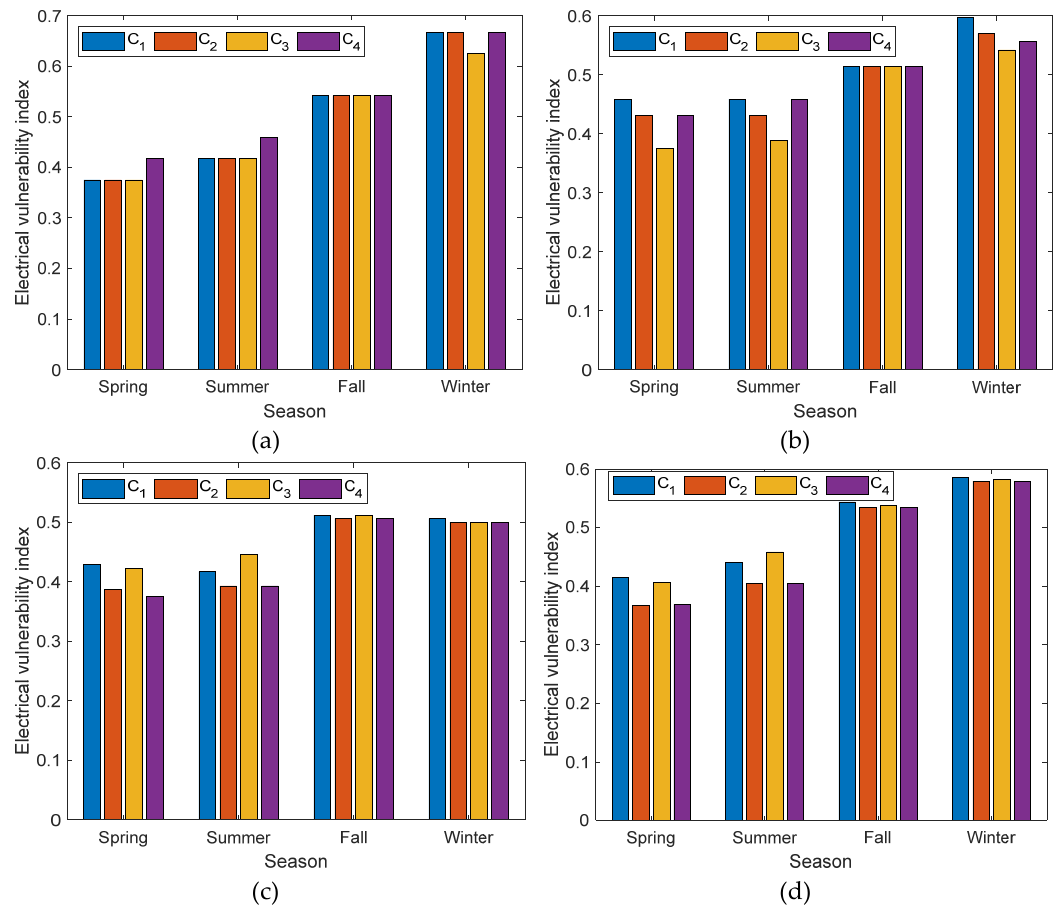
Figure 8. Electrical vulnerability analysis of NU combinations for ( a ) S1-A, ( b ) S1-B, ( c ) S1-C, and ( d ) S1-D